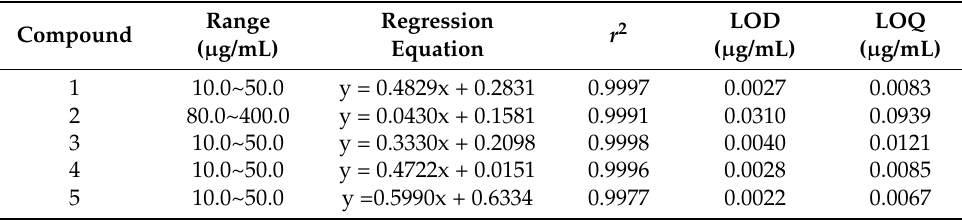
Table 4. Calibration curves of compounds and LOD, LOQ.